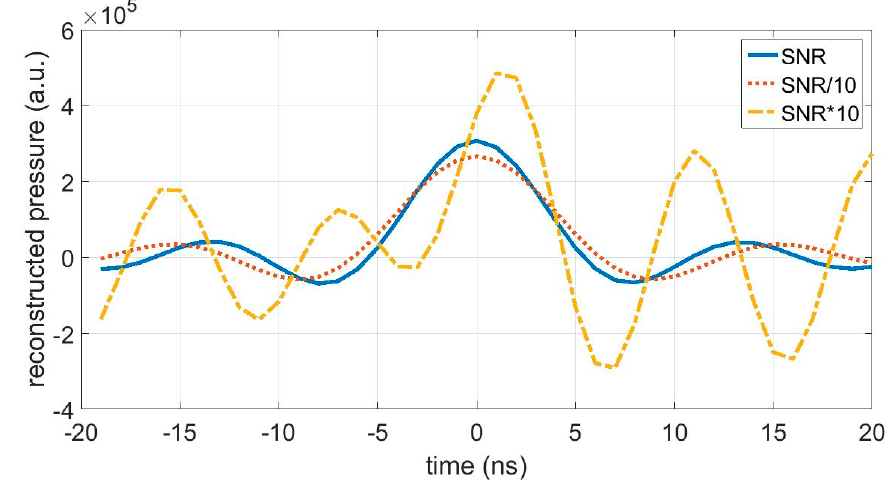
Figure 5. Reconstructed ideal waves for the signal at a distance 24.65 mm where the signal-to-noise ratio (SNR) of 570 for the reconstruction is divided by 10 (dotted line) or multiplied by 10 (dashed line). The width of the reconstruction gets higher for a lower SNR, because the truncation frequency is reduced. The truncation frequency is shifted from 93 MHz (Table 1) to 80 MHz, and the spatial resolution degrades from 8.1 µ m (Table 2) to 9.3 µ m. If a higher SNR is assumed than that provided by the experimental data, large artifacts caused by the high amplification of the fluctuations appear. In that case, proper reconstruction is not possible (dashed line). By such a SNR, the truncation frequency would be shifted from 93 MHz to 114 MHz, and the spatial resolution would be enhanced from 8.1 µ m to 6.6 µ